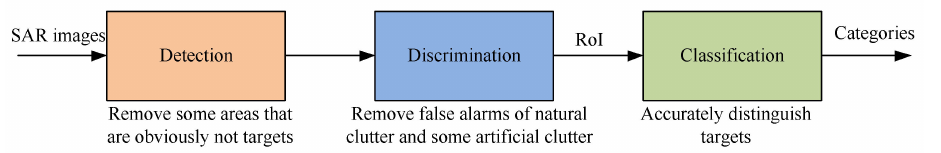
Figure 1. The process of SAR ATR.